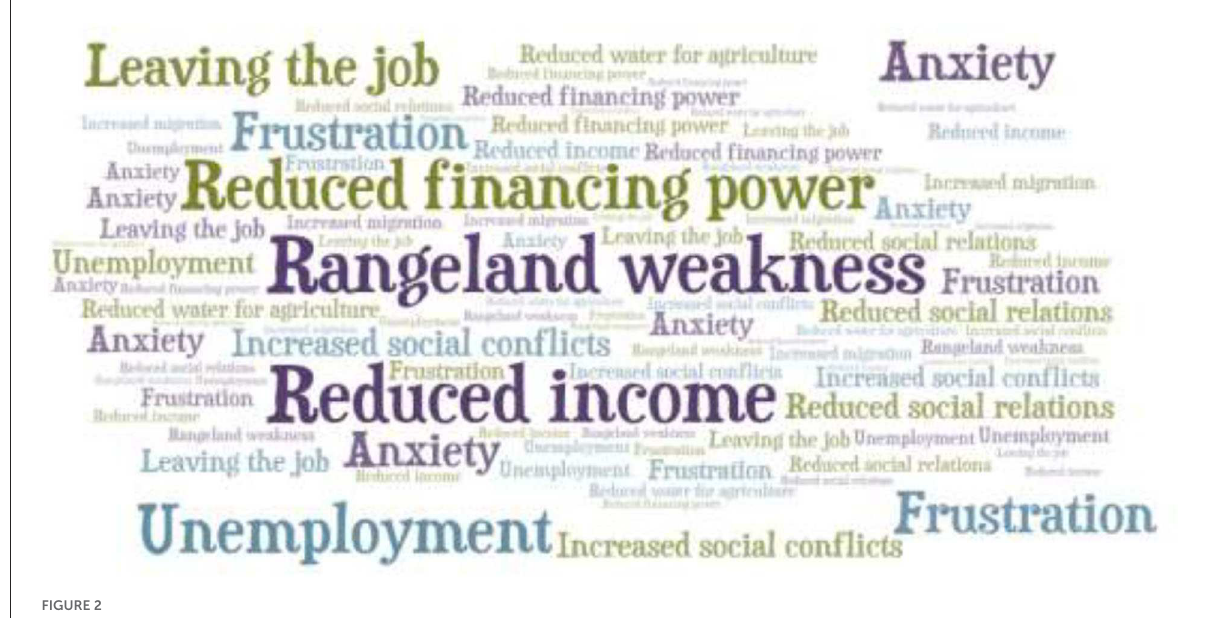
FIGURE2 Word cloud of the perceived risks of climate